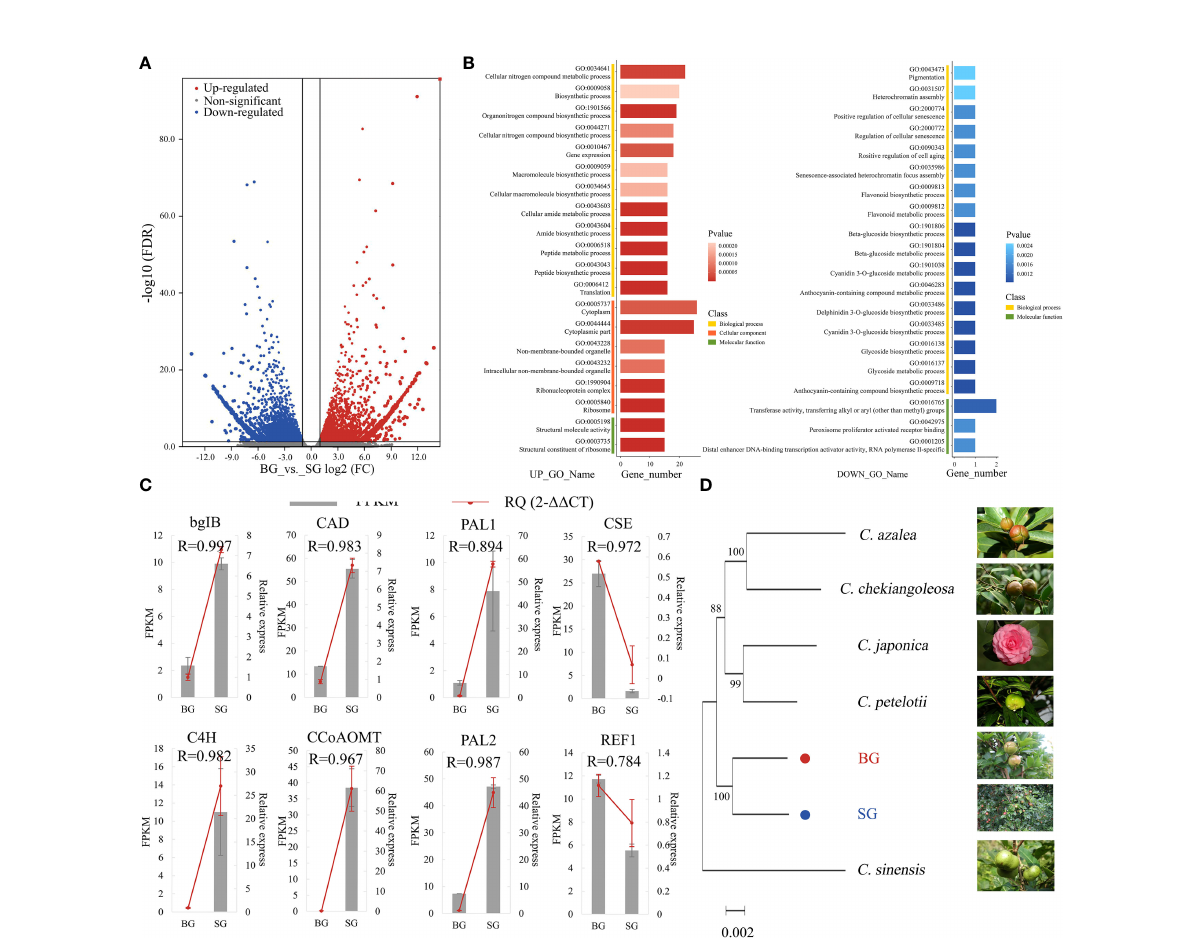
FIGURE 3 Transcriptome data comparison between BG and SG. (A) Volcano plot analysis of differentially expressed genes (DEGs), |log2(FC)|>1; (B) Gene Ontology (GO) functional annotation terms (UP_TOP 20 and DOWN_TOP 20) (C) Comparison of the expression levels of eight lignin genes in FPKM and RT-PCR. Error bars represent SE. (D) Molecular phylogenetic analysis by the maximum likelihood method of single-gene orthologs in seven Camellia